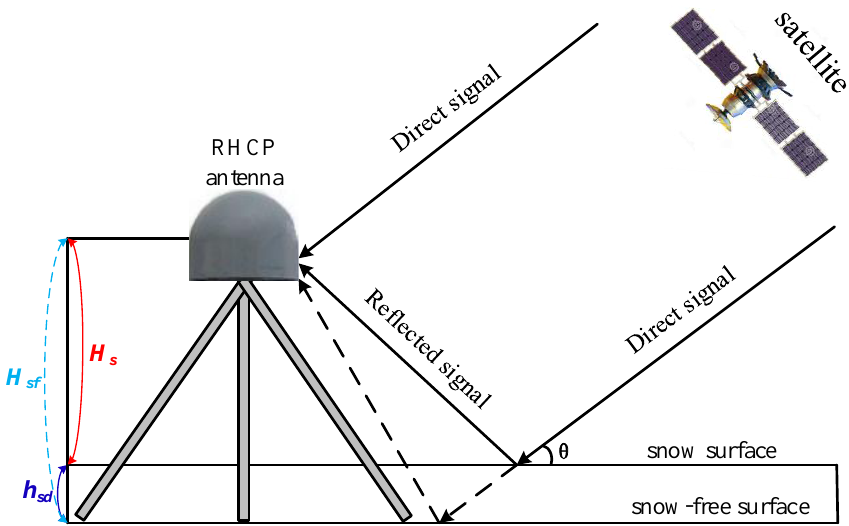
Figure 1. Schematic diagram of GNSS-IR snow depth retrieval. After the satellite sends the signal, the right-handed circular polarized (RHCP) antenna receives the direct signal and the surface reflected signal, and produces interference effect at the receiver. The snow surface reflector height ( H s ) and snow-free surface reflector height ( H sf ) are calculated, respectively, by analyzing the oscillation effect, and the snow depth ( h sd ) is calculated by comparing the differences between them. θ is the elevation angle of the satellite.